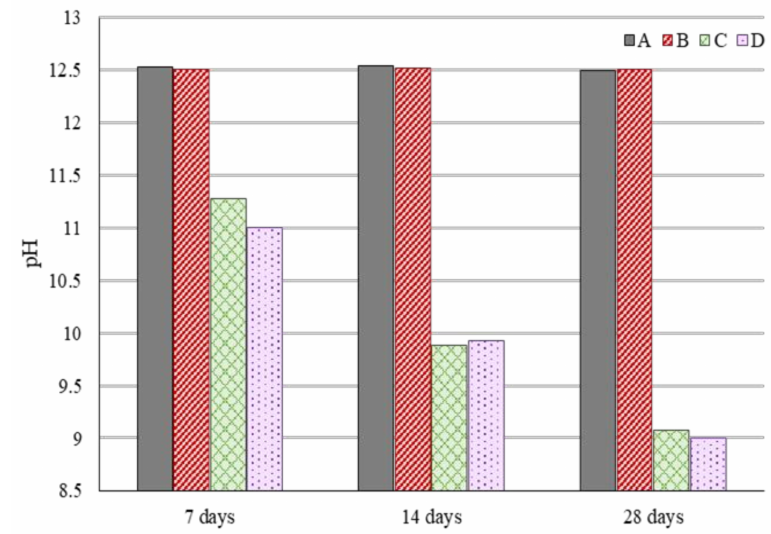
Figure 8. pH evolution of paste specimens after 7, 14, and 28 days of